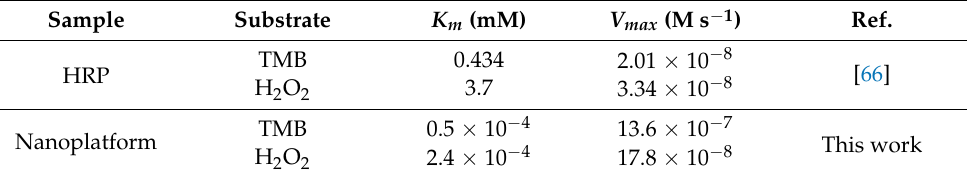
Table 1. Comparison of the calculated kinetic parameters ( V max and K m ) for the peroxidase-mimic magnetite/Gd 3+ / β -cyclodextrin nanoplatform with HRP.